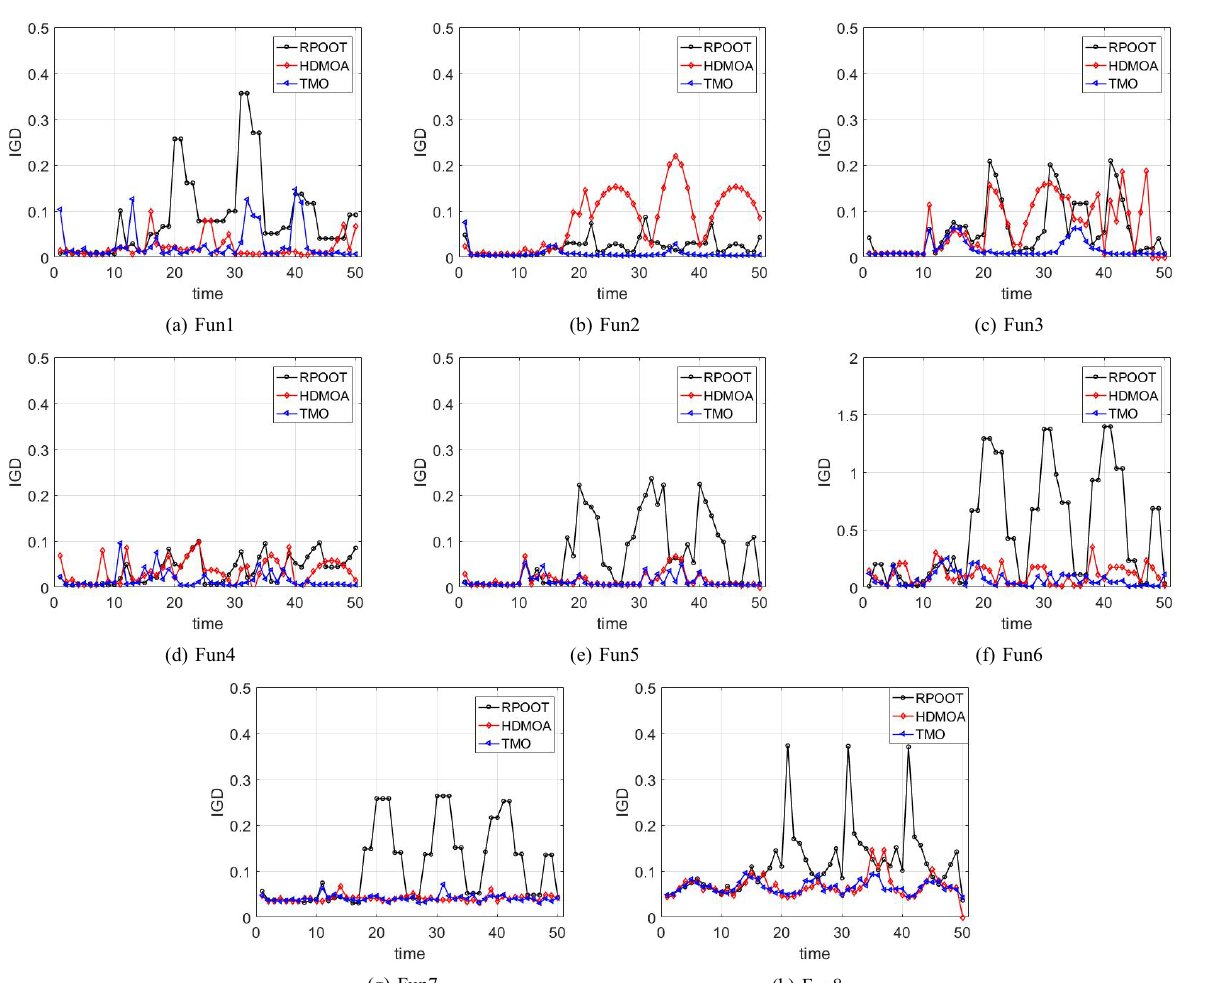
Fig. 4 IGD comparison for each time among three methods under linear environmental changes